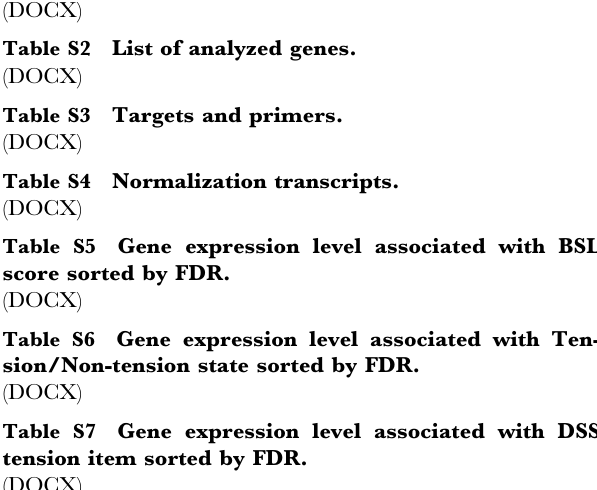
sion/Non-tension state sorted by FDR.